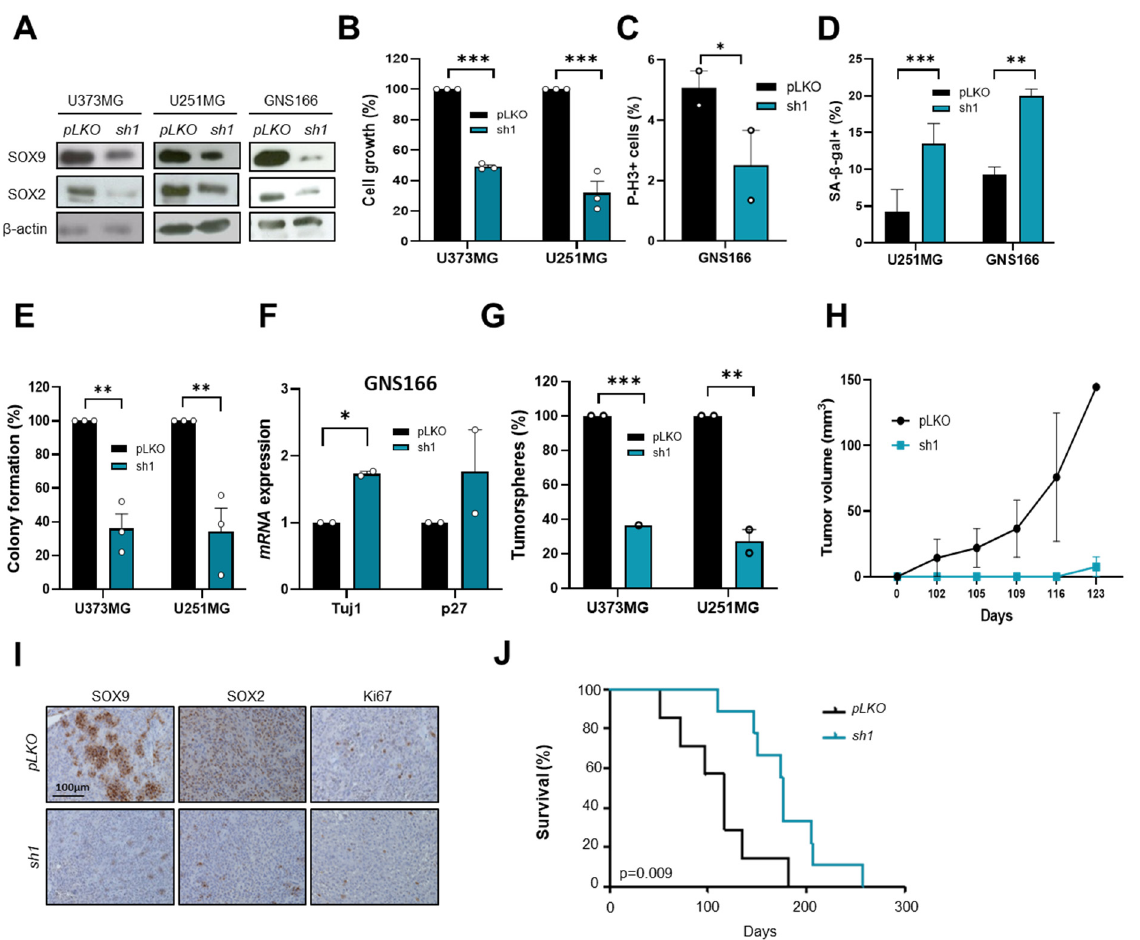
Figure 3. SOX9 knockdown impairs tumorigenicity: ( A ) representative immunoblot of SOX9 and SOX2 expression in glioma cells with SOX9 downregulation ( shSOX9-1 ; sh1 ) and controls ( pLKO ). β -actin was used as loading control ( n = 3); ( B ) quantification of cell growth in control and sh1 U373-MG, U251-MG cells at day 5 ( n = 3); ( C ) quantification of P-H3 + GNS166 cells infected with pLKO or sh1 plasmids ( n = 3); ( D ) quantification of SA- β -gal + cells in sh1 and control cells ( n = 3); ( E ) quantification of number of colonies formed from glioma cell lines infected with pLKO or sh1 plasmids ( n = 3); ( F ) expression of Tuj1 and p27 KIP in GNS166 cells infected with pLKO or sh1 plasmids ( n = 2); ( G ) quantification of primary tumorspheres after 10 days in culture ( n = 3). Quantifications are expressed relative to pLKO ; ( H ) tumor volume of subcutaneous tumors generated by pLKO - and sh1 -infected U373-MG cells ( n = 4); ( I ) SOX9, SOX2, and Ki67 IHC staining from subcutaneously generated tumors in “ pLKO ” and “ sh1 ” groups. Scale bar corresponds to 100 µ m; ( J ) Kaplan–Meier curves representing mice survival after stereotactic injection of pLKO and sh1 GNS166 cells. * p < 0.05, ** p < 0.01, *** p <